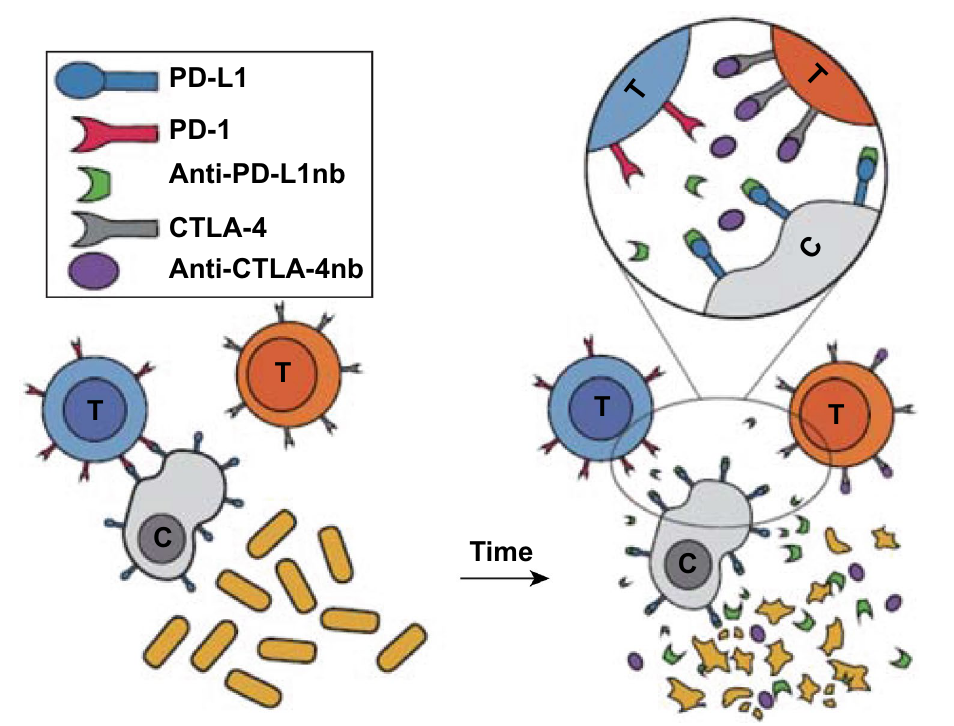
Fig. 8 Schematic diagram of engineered bacteria delivering immune checkpoint inhibitors. Engineered bacteria carrying immune checkpoint inhibitors gather in the core of the tumor, grow to a critical density and lyse, thereby continuously releasing therapeutic agents at the tumor site to treat cancer. Reprinted with permission from Ref.